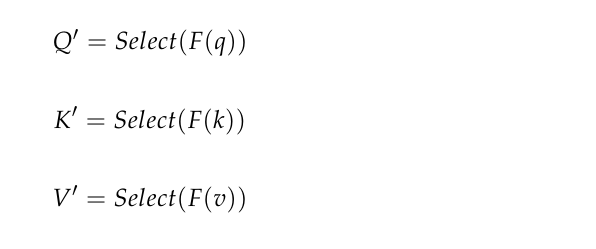
Figure 3. Frequency Enhanced Attention module.